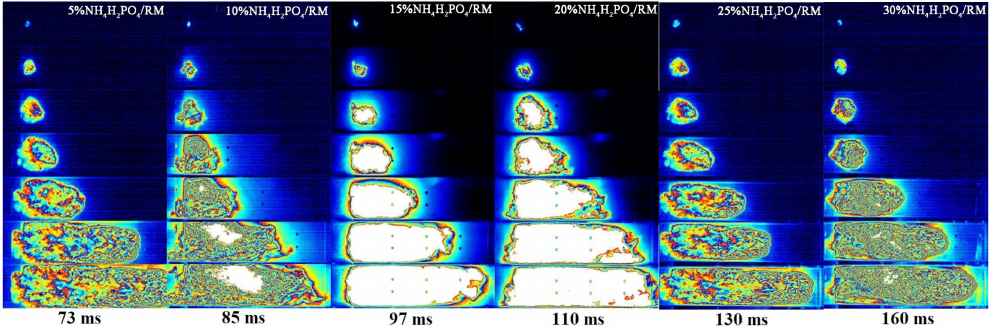
Figure 7. The images of explosion flame in different conditions: no powder, red mud, NH 4 H 2 PO 4 and the NH 4 H 2 PO 4 /RM composite powders with different content of NH 4 H 2 PO 4 .